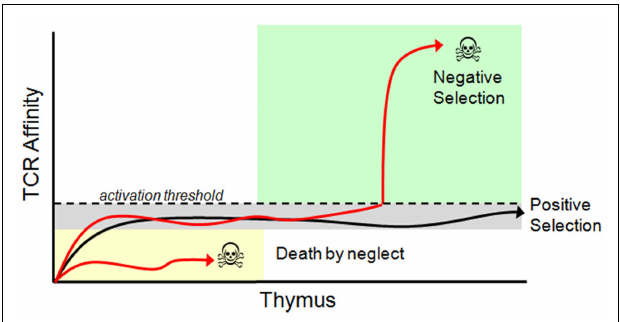
FIGURE 4 |Thymic selection ofT cells. ImmatureT cells (called thymocytes) enter the thymic cortex and undergo differentiation. During this timeTCR re-arrangement occurs until an activeTCR is expressed along with both the CD4 and CD8 co-receptors.Those thymocytes that have a functionalTCR and survive commit to a single positive (SP) state (SP thymocytes express either CD4 or CD8, but not both), and migrate to the thymic medulla. Here, SP thymocytes systematically scan medullary thymic epithelial cells and dendritic cells presenting self-peptides in their MHC molecules. During the SP thymocyte stage, any thymocyte that expresses aTCR that has an above threshold affinity to self-peptides undergoes apoptosis and dies. Surviving thymocytes eventually exit the thymus and enter the periphery as mature, naïveT cells. Positive and negative selection is determined byTCR affinity to their peptide/MHC ligand. Once aTCR is expressed on the cell surface it immediately begins interacting with MHC molecules presenting self-peptides. FunctionalTCR’s generate a basal signal output that, although insufficient to cross the activation threshold, is still necessary for thymocyte survival.TCR’s that cannot recognize peptide/MHC complexes ultimately die by neglect. Surviving thymocytes then migrate to the thymic medulla where they are exposed to self-antigen. AnyTCR that reacts with a self-peptide with too high of an affinity will induceT cell activation and apoptosis. Only thymocytes with a functional TCR, which is competent to trigger low-level signaling but does not cross the activation threshold to self-peptides, is positively selected and permitted to exit the thymus. Modified fromWhitacre et al. (2012).